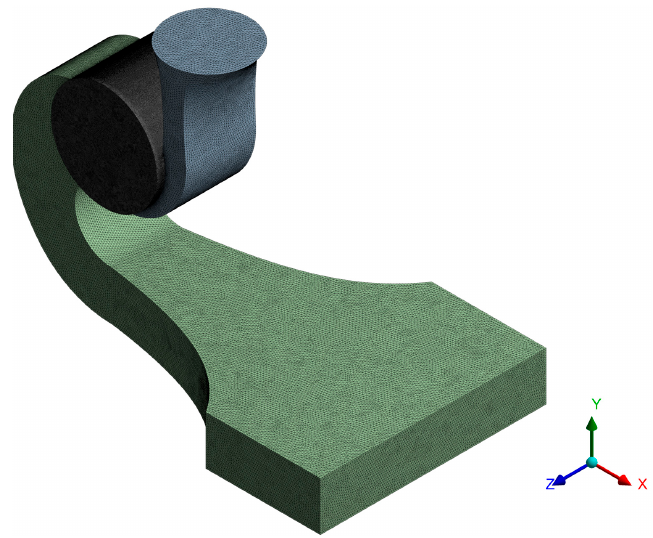
Figure 9. Trimetric view of the UL-PRS 1 3D Grid scheme.